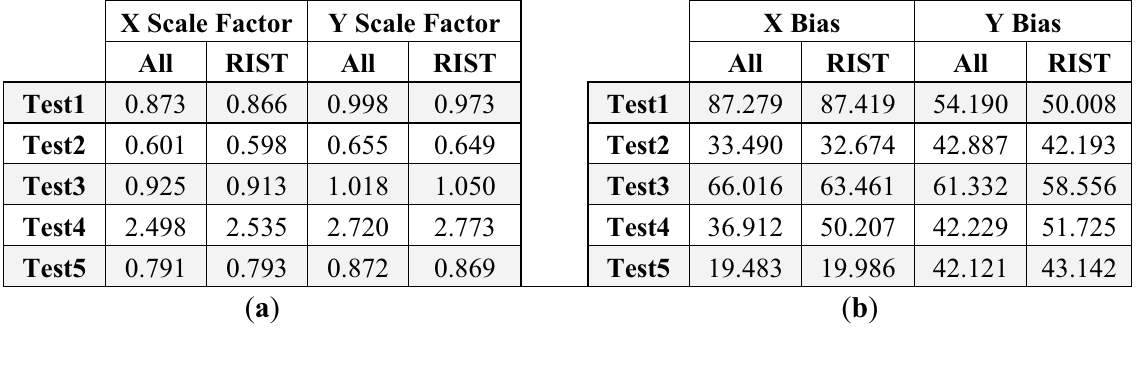
Table 1. Magnetometer parameters values resulted from using the entire dataset and applying RIST in 2-D calibration. ( a ) Scale factor. ( b )